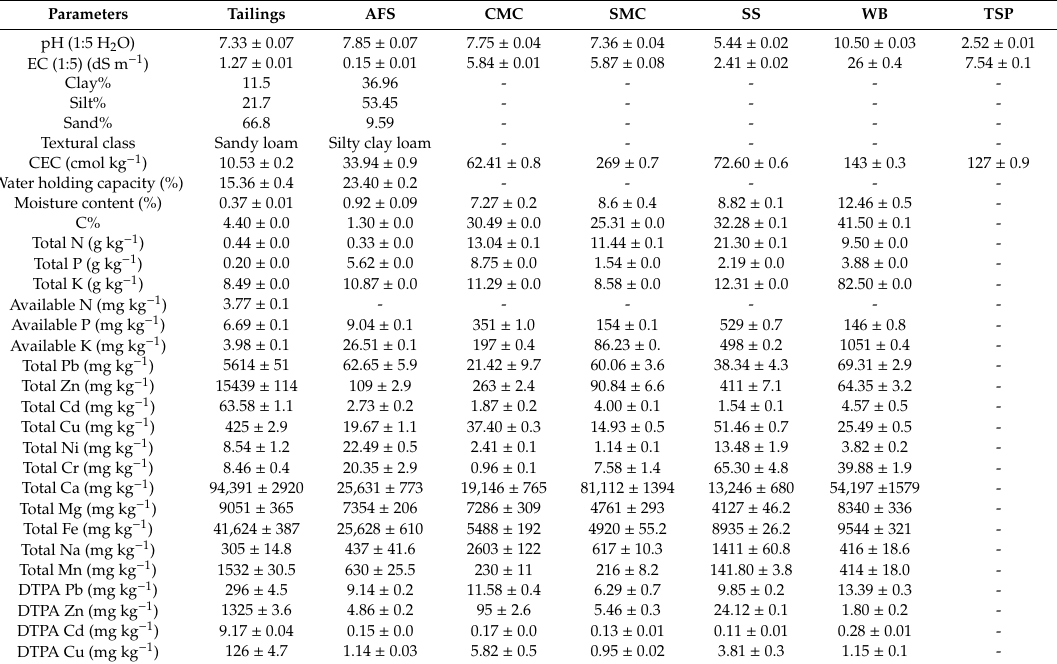
Table 2. Basic physicochemical properties of the studied Pb-Zn mine tailings and amendments (mean ± standard deviation; n =